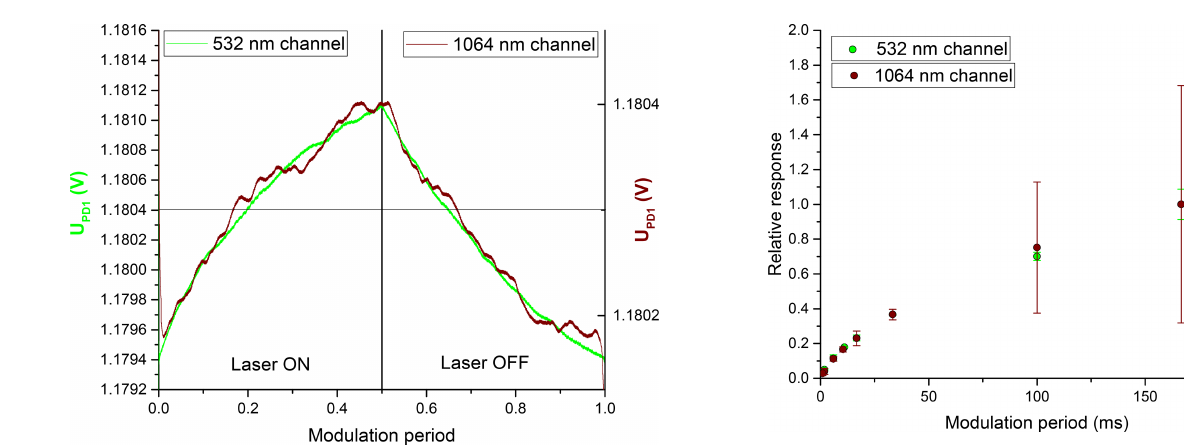
Figure 3. Average photodiode voltage during the heating and cool- ing parts of the modulation period for the 532 and the 1064nm channels obtained for nigrosin particles. The duration of the mod- ulation period is 11.1 and 10.4ms, respectively. The curves are ob- tained by averaging the photodiode PD1 voltage over more than 10000 modulation periods.